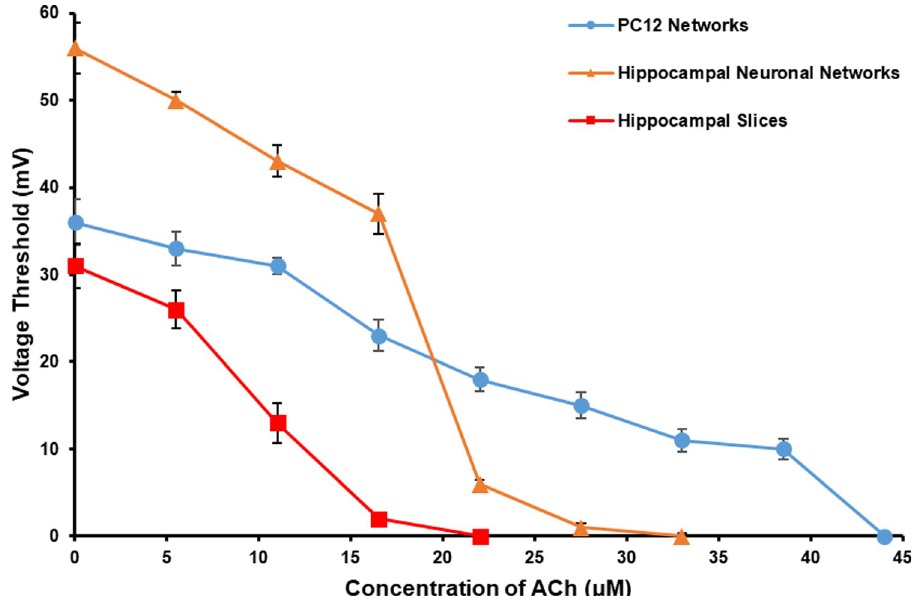
Fig 7. The V Th of the three types of neuronal networks under the effect of ACh in different concentrations ( n = 5). https://doi.org/10.1371/journal.pone.0265078.g007 The changes of V of the three types of neuronal networks under the effect of LDH in dif- Th ferent concentration were shown in Fig 10. LDH had very similar concentration-dependent effects on all the three networks. To be specific, low concentration of LDH had an inhibitory effect on the three types of neuronal networks and the effect strengthened with the increase of